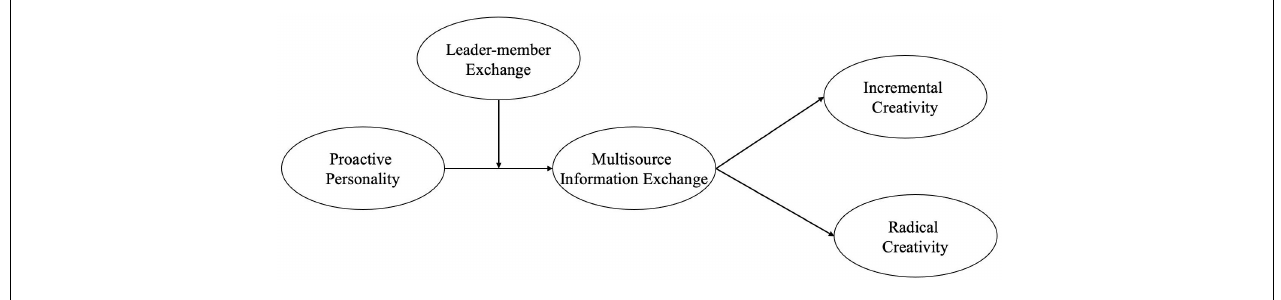
FIGURE 1 | Research